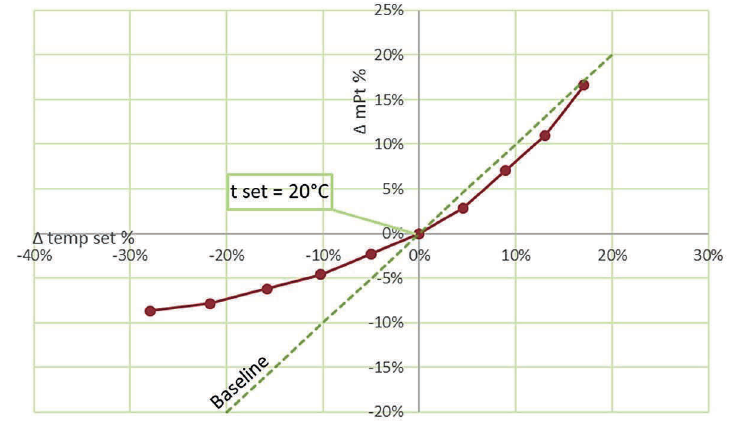
Fig. 13. Greenhouse temperature relation to environmental impact